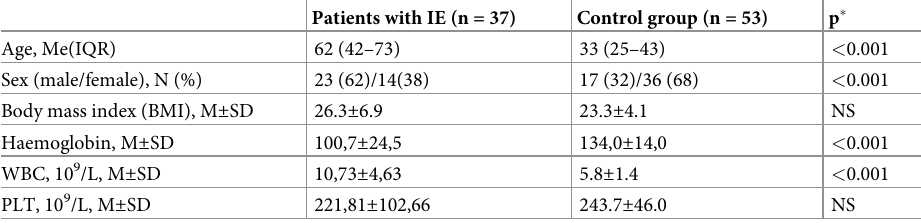
Patients with IE (n =